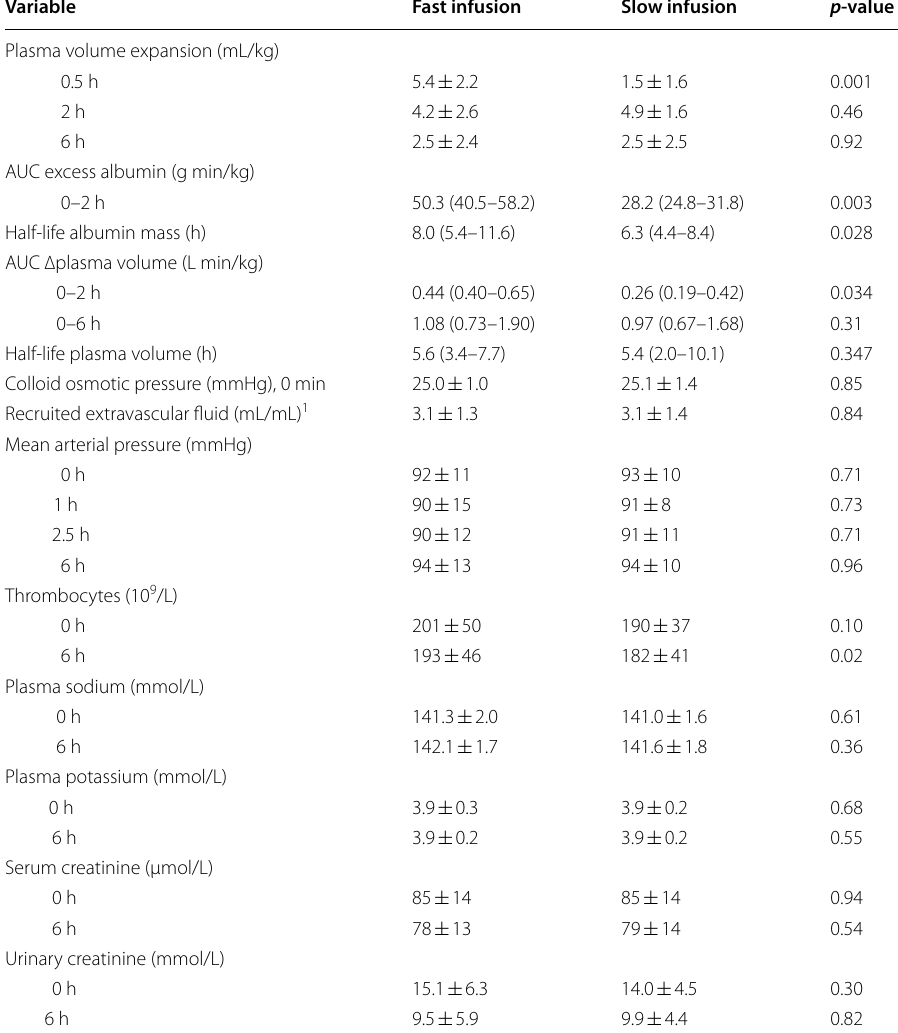
Table 1 Demographic and clinical characteristics of the participants in the 20% albumin infusion